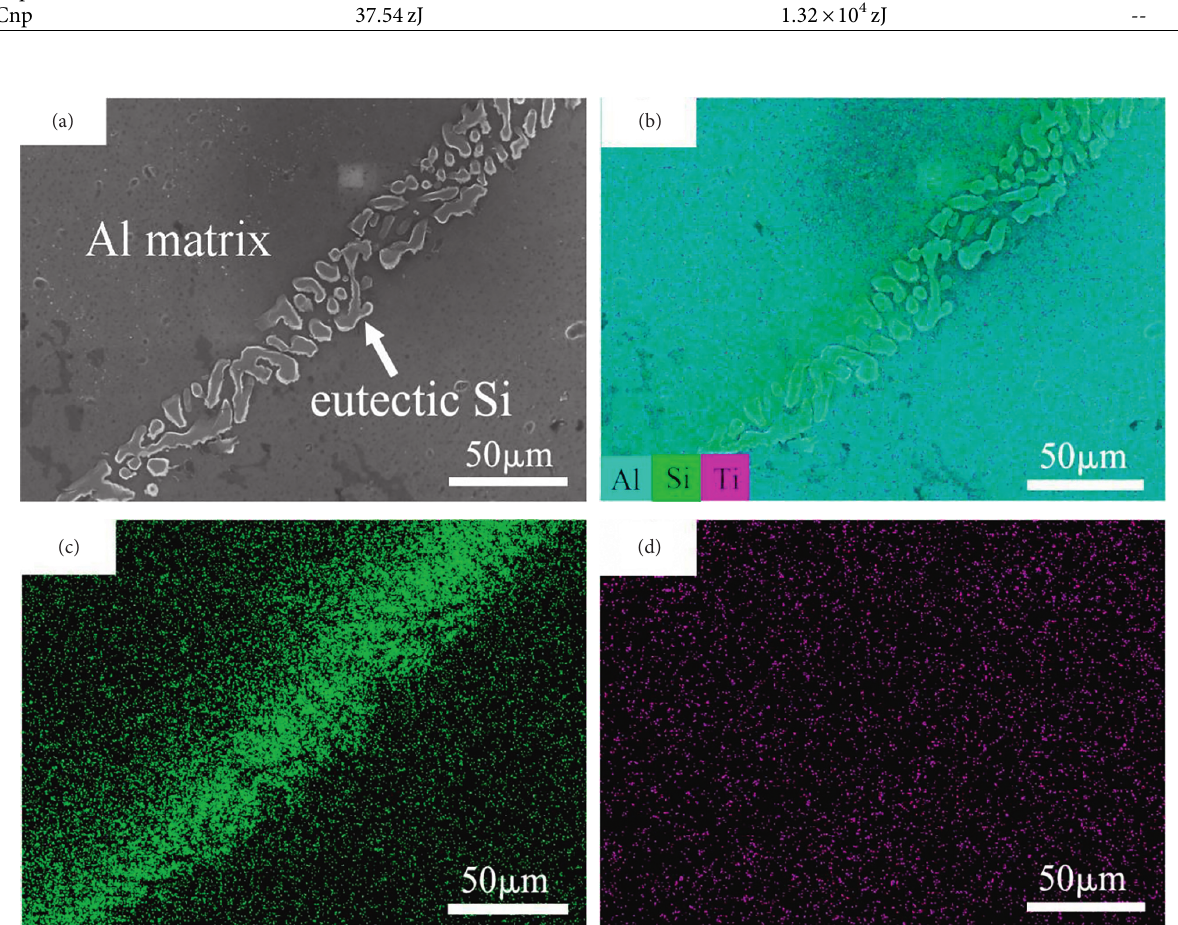
Figure 5: EDS of eutectic structure and α -Al phase of 2 vol% hybrid nano-(SiCp +TiCp)/Al composites: (a) SEM image; (b) distribution of nano-SiCp and -TiCp; EDS of (c) Si K and (d) Ti